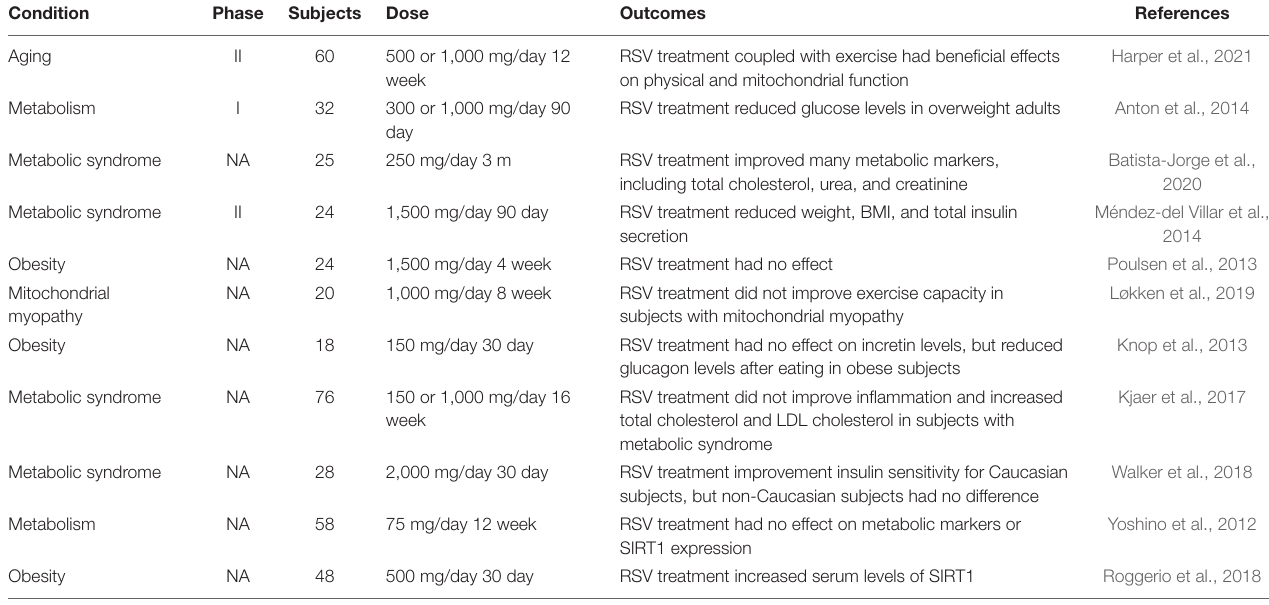
TABLE 7 | Clinical trials of resveratrol for obesity and metabolic disorders.